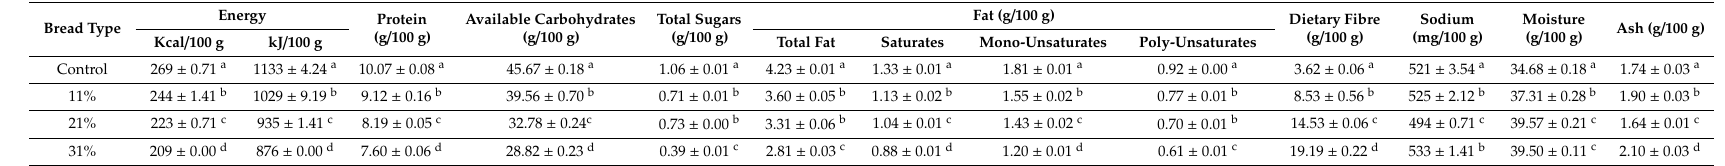
Table 5. Proximate composition of control bread, and 11%, 21% and 31% of BBH fortified